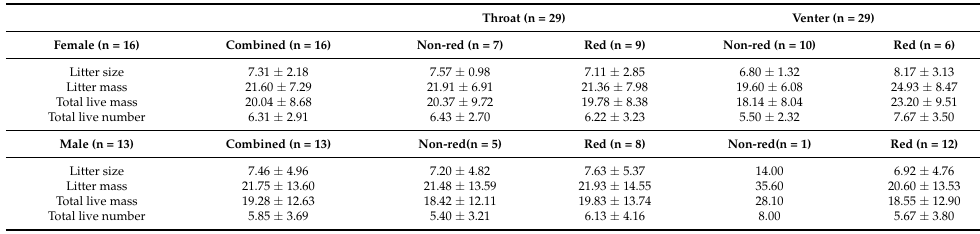
Table 4. Summary of means and standard deviations of reproductive output (offspring) traits for two colour variants (non-red, red) of each body region and sex. No significant difference was found between two colour variants in all